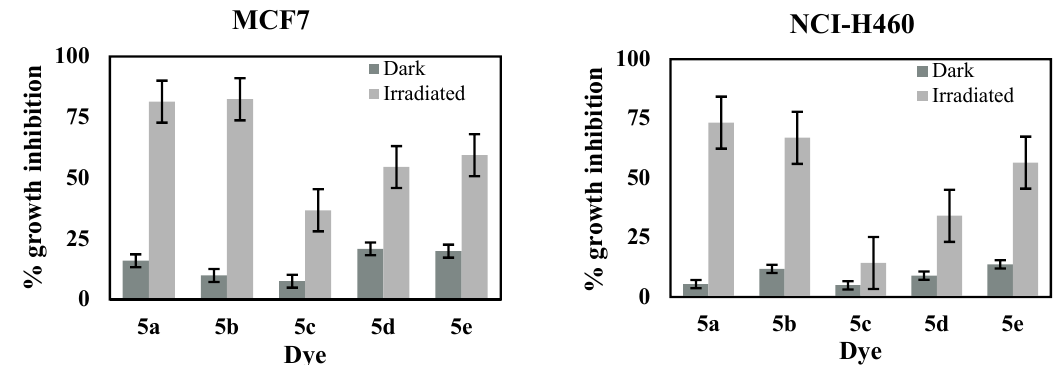
Figure 3. Growth inhibition of HeLa, HepG2, MCF-7 and NCI-H460 cell lines upon treatment with dyes 5a – e (0.3 µ M) in the dark and after irradiation. Results correspond to two independent assays and are presented as mean values ± standard deviation (SD).